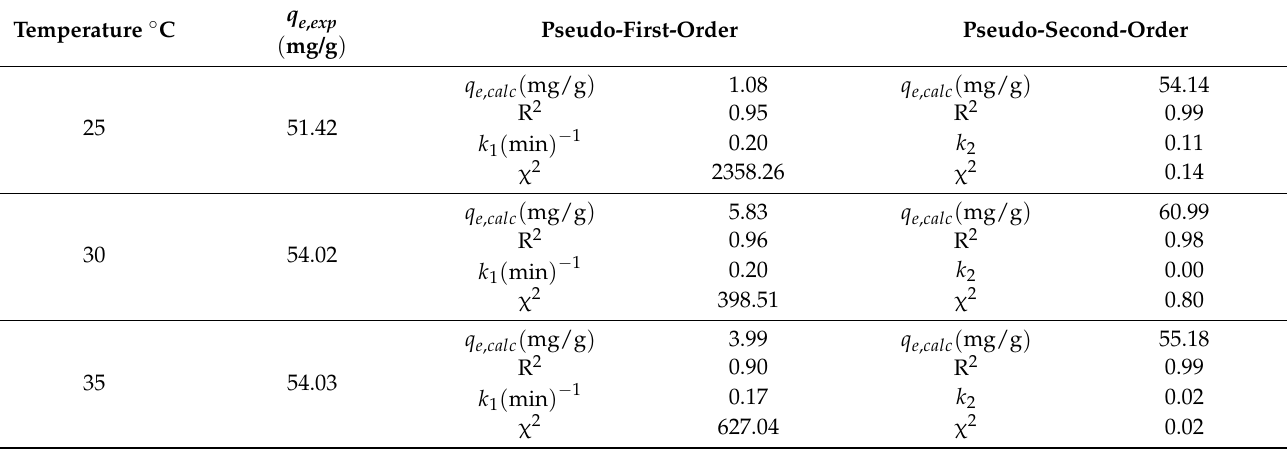
Figure 5. Weber–Morris intra-particle diffusion model of Pb 2+ ion sorption onto the modified ZnO NP/DPF sorbent at different temperatures: 25 °C ( a ) , 30 °C ( b ) , 35 °C ( c ), 45 °C ( d ), 50 °C ( e ), and 55 °C ( f ). Table 1. Pseudo-first- and second-order kinetic parameters of lead (II) retention by the modified sorbent ZnO NP/DPF at different